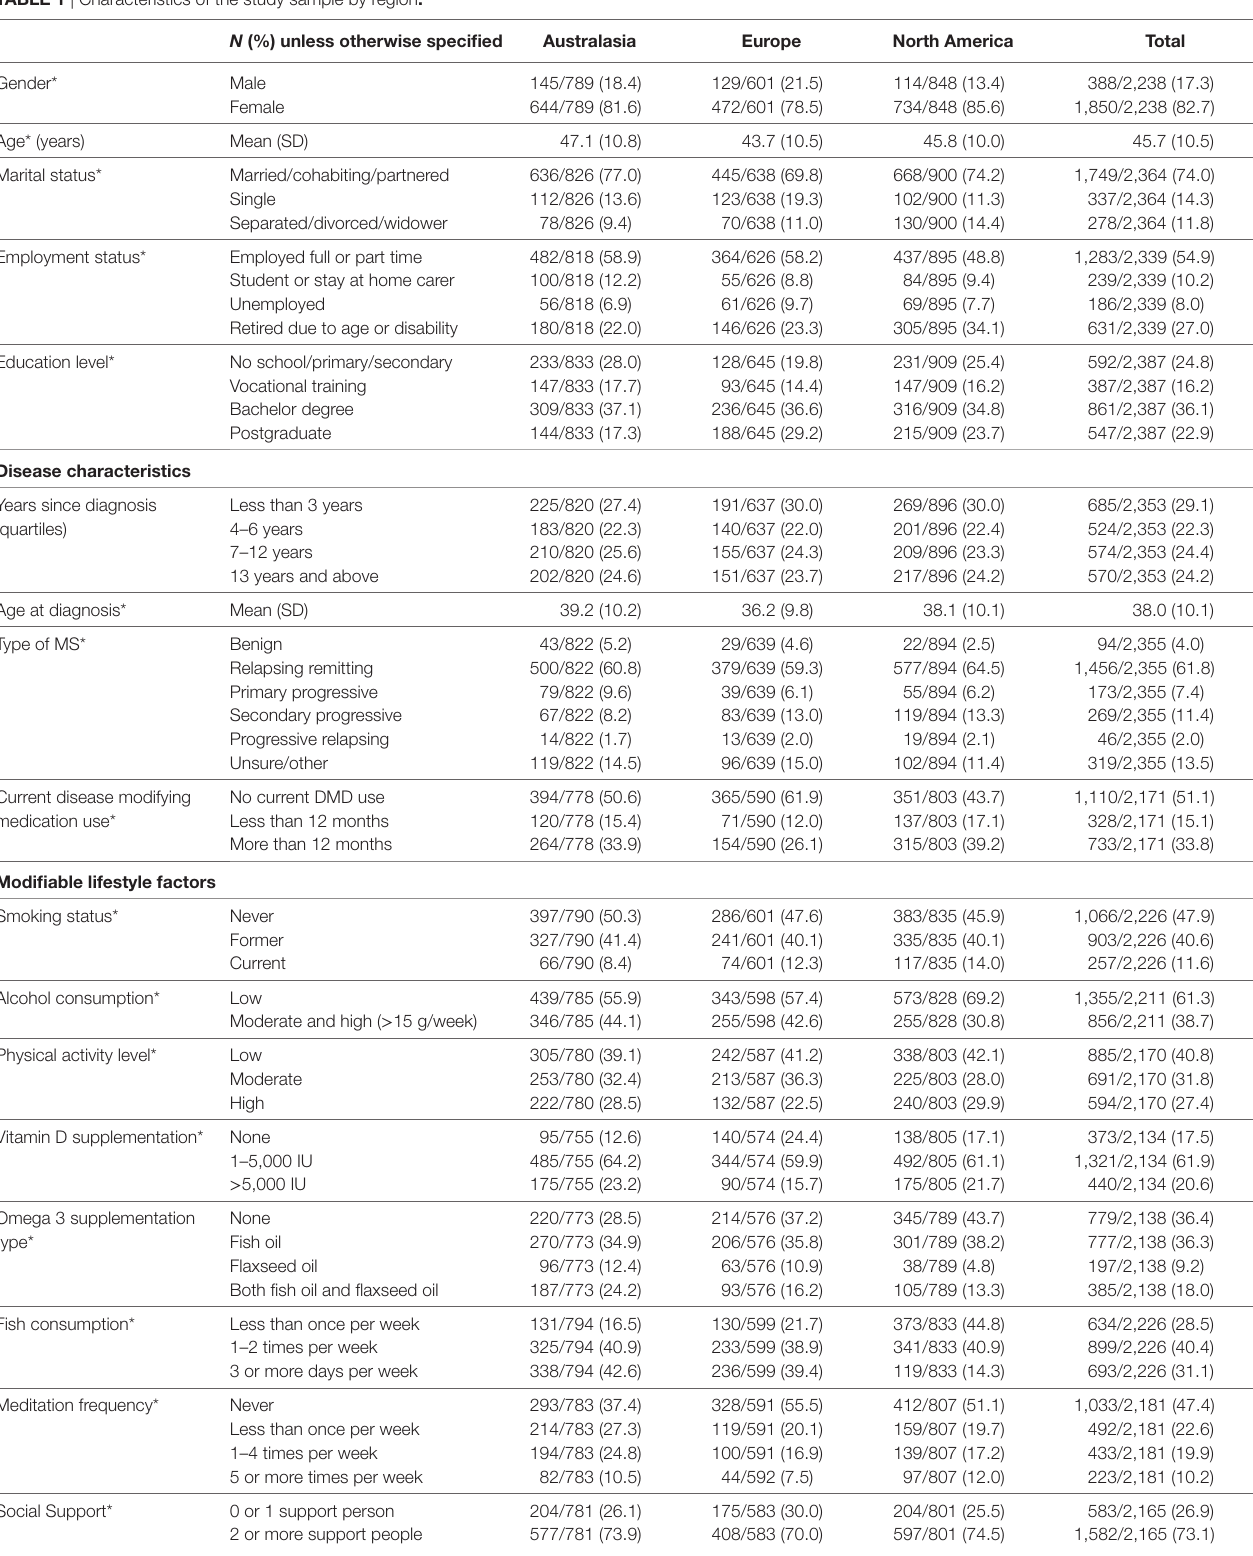
Table 1 | Characteristics of the study sample by region